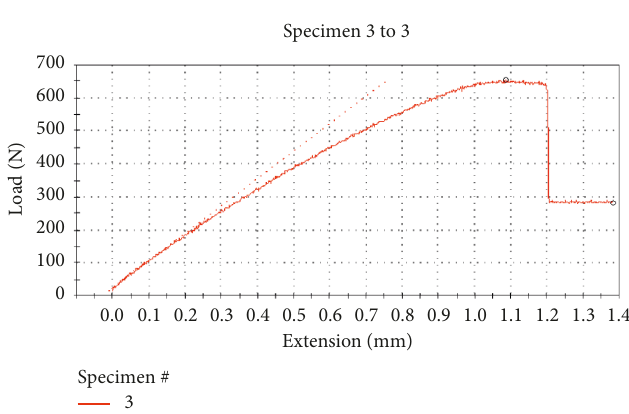
Figure 8: Tensile load-extension curve for specimen III.